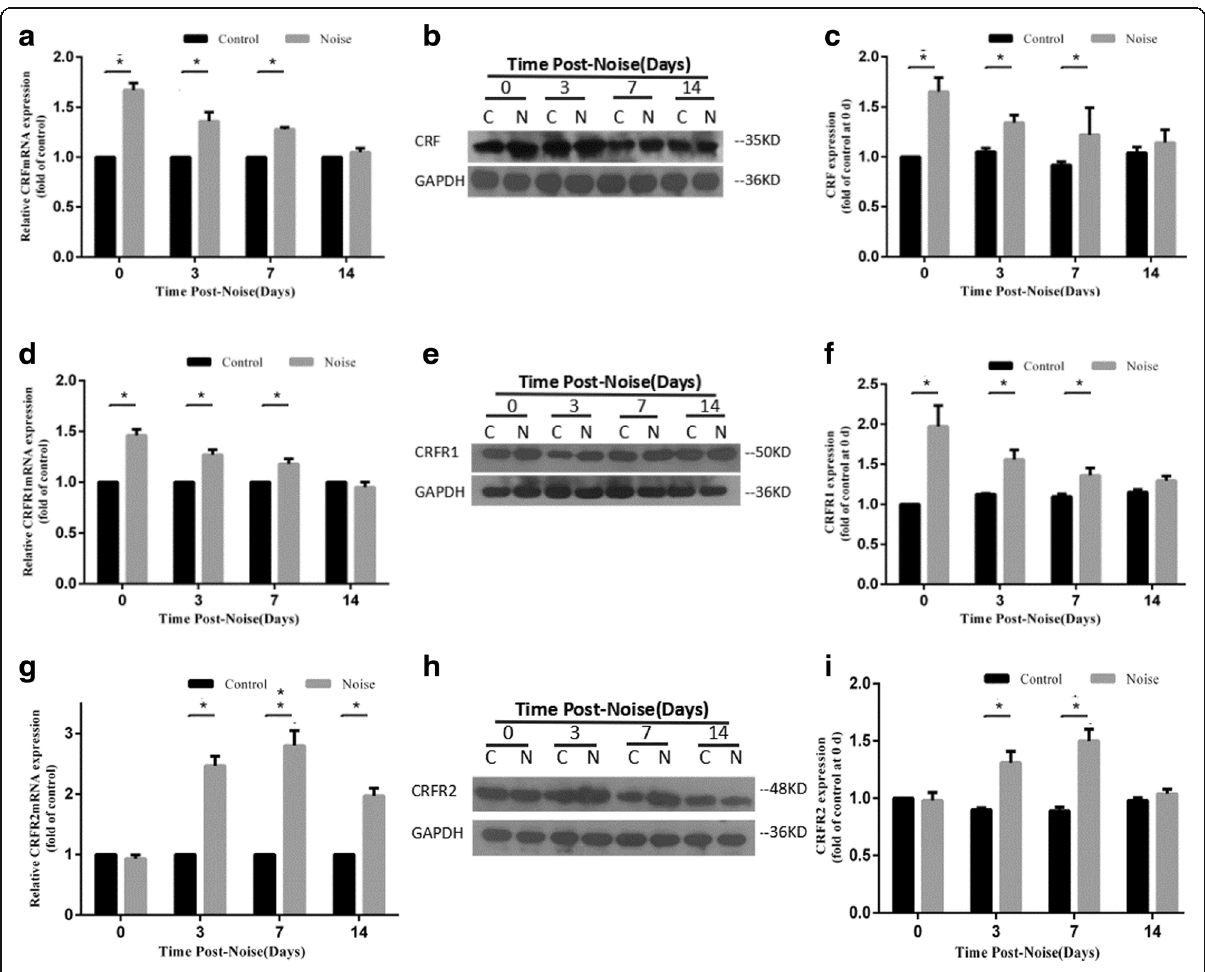
Fig. 2 Chronic noise exposure increases the expression of CRF, CRFR1, and CRFR2 in the hippocampus. Comparison of CRF , CRFR1 , and CRFR2 mRNA expression levels in control and noise-exposed rats by quantitative real-time PCR at various time points following the cessation of noise exposure ( a , d , g ). Western blot analysis of hippocampal CRF, CRFR1, and CRFR2 expression under C (control) and N (chronic noise exposure) conditions ( b , e , h ). GAPDH was used as a loading control. Quantification of immunoreactive band density measured in panels b , e , and h was normalized against GAPDH ( c , f , i ). Data are presented as the percentage changes relative to control samples. Bars represent means±SD * p <0.05, compared with respective controls ( n =6 per